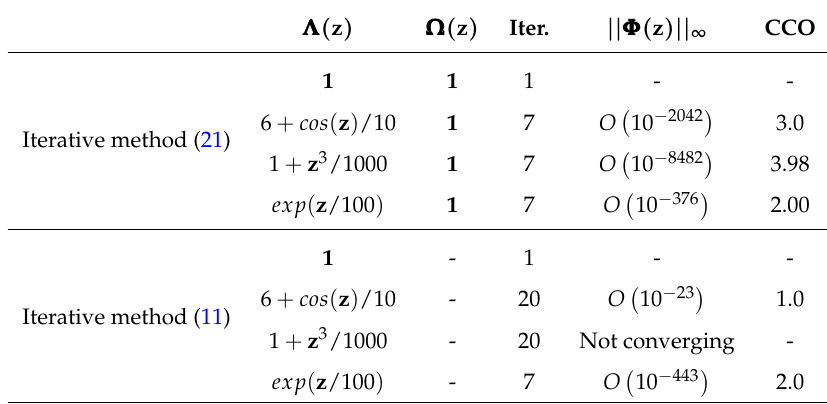
Table 2. Problem 2: initial guess = [ 1,2,4,3 ] , m = [ 2,2,2,2 ] .